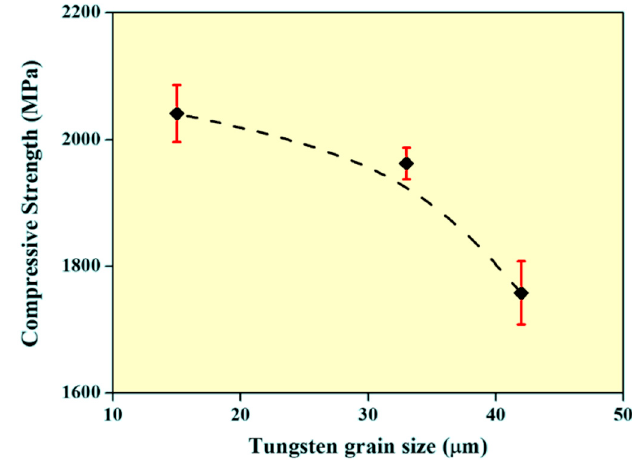
Figure 7. Variation of compressive strength with W grain size (as a function of different sintering